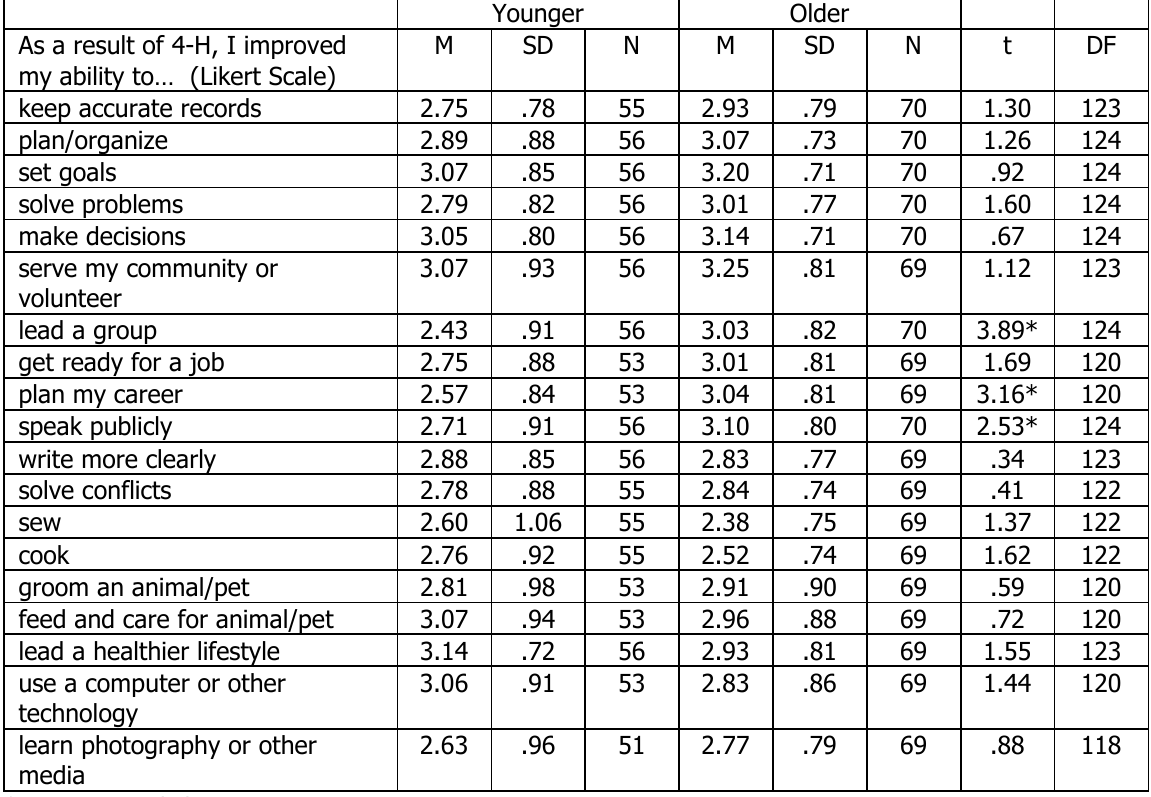
Table 8. Only those correlations higher or equal to .30 will be mentioned here. Those participants that actually spoke before a group more frequently had an increase in their ability to speak publicly (r=.50, p<.01), lead a group (r=.49, p<.01), and make decisions (r=.35, p<.01). Those who felt successful more frequently had an increase in their ability to make decisions (r=.37, p<.01), solve problems (r=.36, p<.01), groom an animal/pet (r=.34, p<.01), keep accurate records (r=.32, p<.01), lead a group (r=.31, p<.01), serve